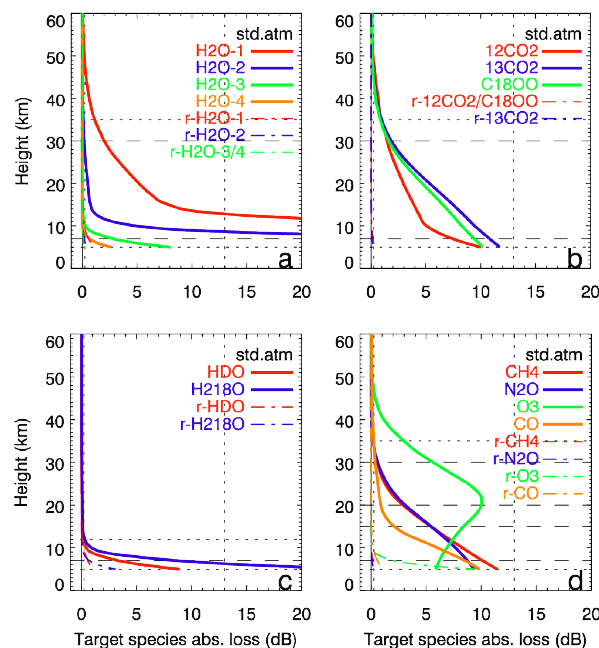
Fig. 4. Target species absorption loss for the 13 absorption channels and total absorption loss for the six reference channels listed in Table 1. The situation is shown for the FASCODE STD atmosphere. Absorption channels are marked by solid lines, reference channels (at or near zero dB ) by dashed-dotted lines. The vertical dashed lines mark the lower and upper boundary of favourable signal range. The horizontal dotted and dashed lines mark target and threshold requirements, respectively, regarding the vertical range within which trace species shall be retrieved.